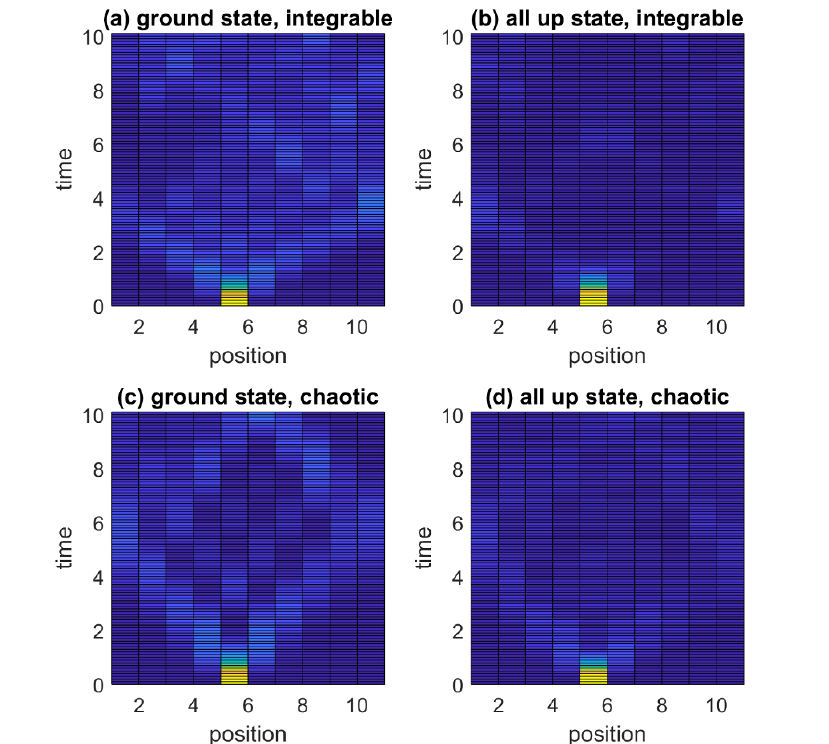
Figure 23 . The averaged quantum causal in(cid:13)uence CI( A : B ) for a quantum spin chain for length-1 regions A and B . Region A is at site 5 in the middle of the chain at time t = 0. The heat maps